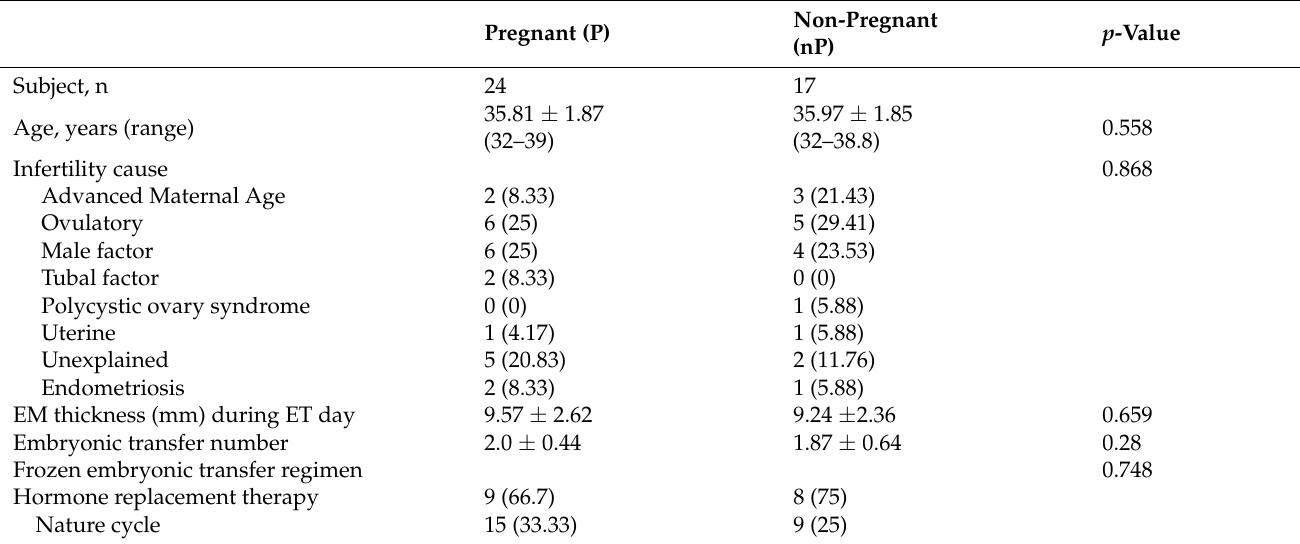
Table 1. Demographic characteristics of all clinical samples with methylation